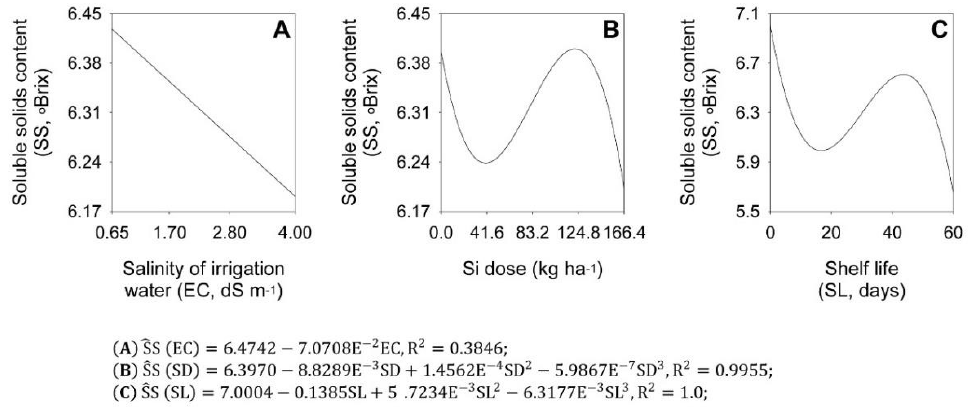
Figure 4. Effect of salinity levels (EC) ( A ), silicon doses (Si) ( B ), and shelf life (SL) ( C ) on soluble solids content (SS) variable in ‘ Rio das Antas ’ onion bulbs.